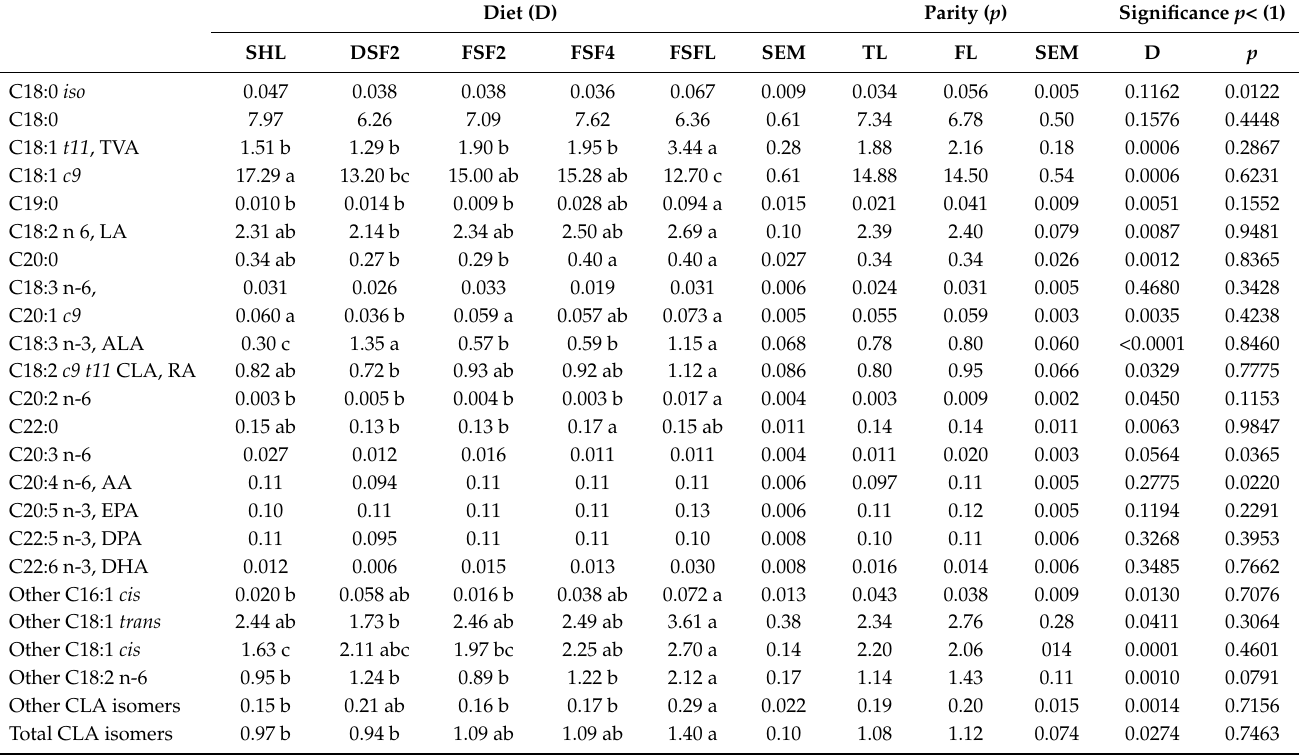
Table 4. The effect of diet and parity on fatty acid (FA) composition (g/100 g FA) of cheese fat: long chain FA.